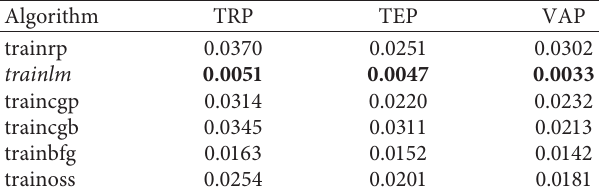
Table 4: Performance of the ANN model with different learning algorithms.